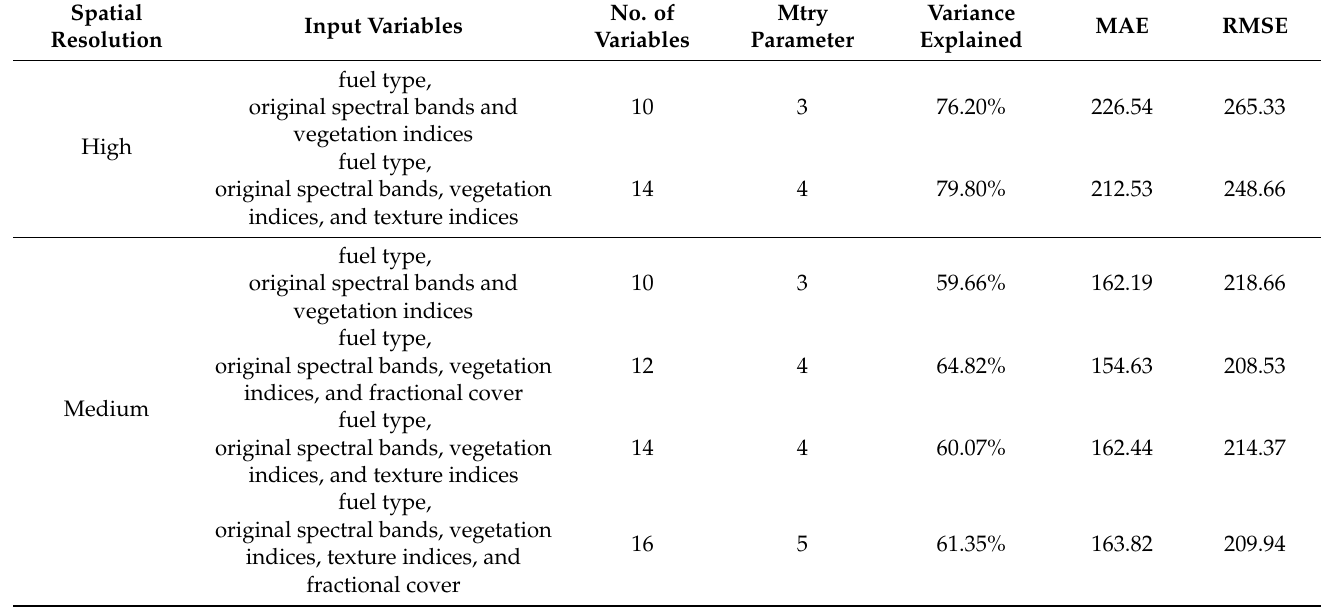
Table 4. The results of the random forest (RF) models used for fine fuel biomass estimation (kg/ha) based on different explanatory variables and different spatial resolution images. The mtry parameter represents the number of randomly selected predictors at each node in the RF analysis. The ntree parameter, which represents the number of trees grown in the model, was set to 500 for all models listed